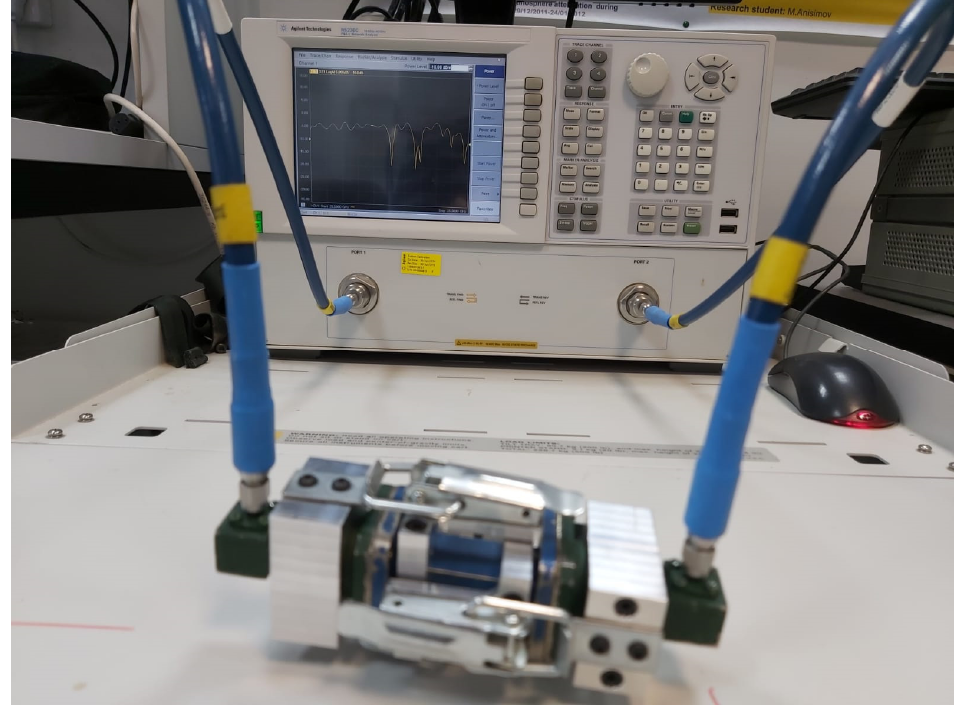
Figure 8. Container and waveguide for the 12–18 GHz frequency range. The spectrum analyzer and the measurement set-up are shown.